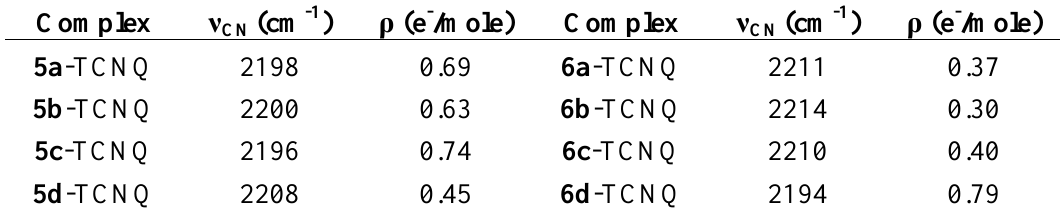
Table 3. Degree of charge transfer of TCNQ